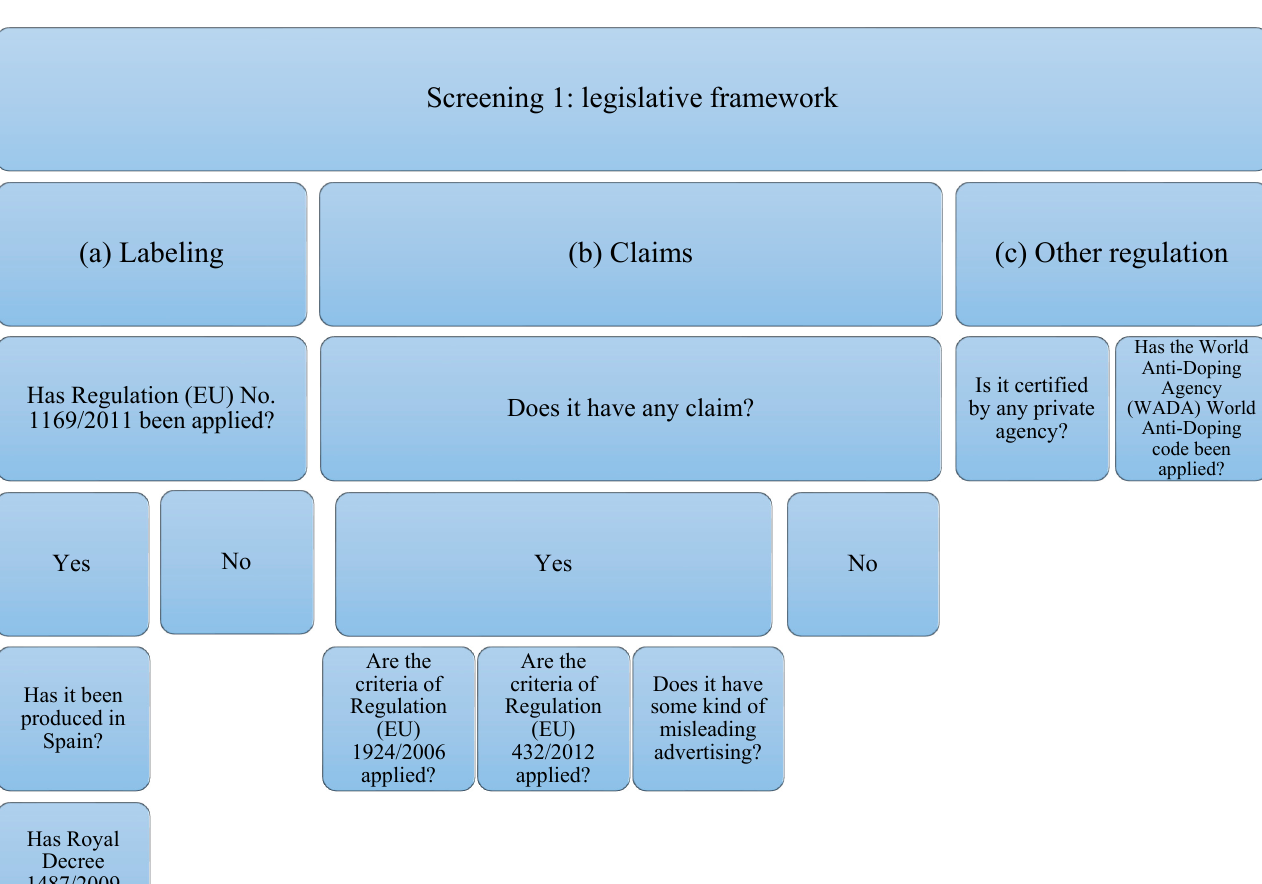
Figure 1. Flowchart Screening 1. The legislation on labeling, claims, and declarations on protein supplements have been taken into account. Claims related to other regulations or certifications by private organizations and the WADA code have also been taken into account.